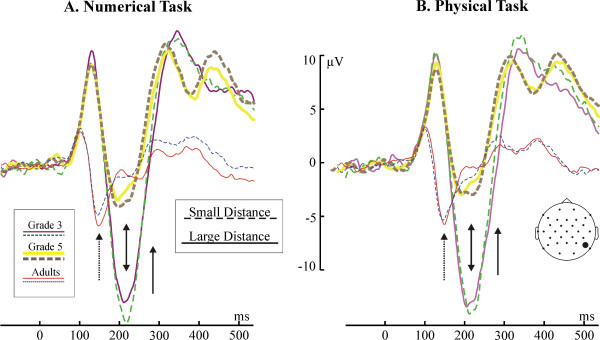
The distance effect in event-related potentials (ERPs) at the parietal electrode P8. Vertical arrows denote distance effects at around 200 ms. The insert denotes the position of electrode P8. (Small distance: distance 1; large distance: distance 5).